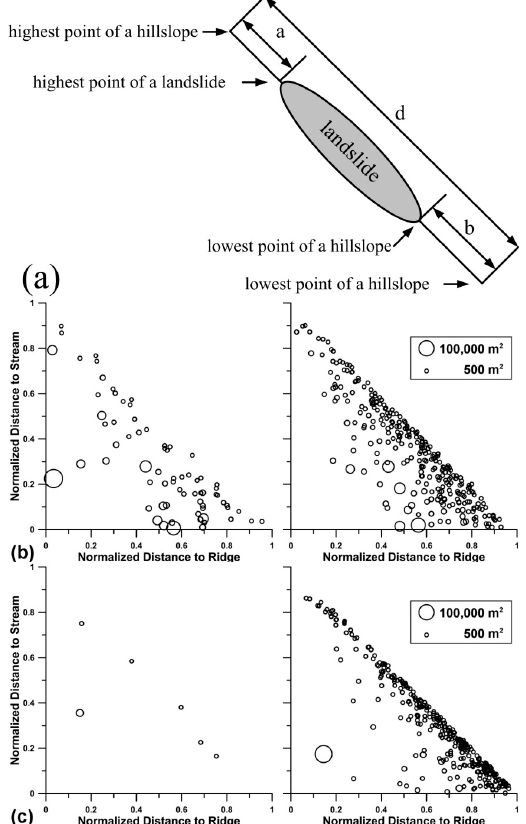
Figure 5. The schematic map of landslide position analysis ( a ); revised from [30]) and the landslide position analysis plots in the NoRW in 2009 (left figure in ( b )) and 2010 (right figure in ( b )), and in the NsRW in 2014 (left figure in ( c )) and 2015 (right figure in ( c )).